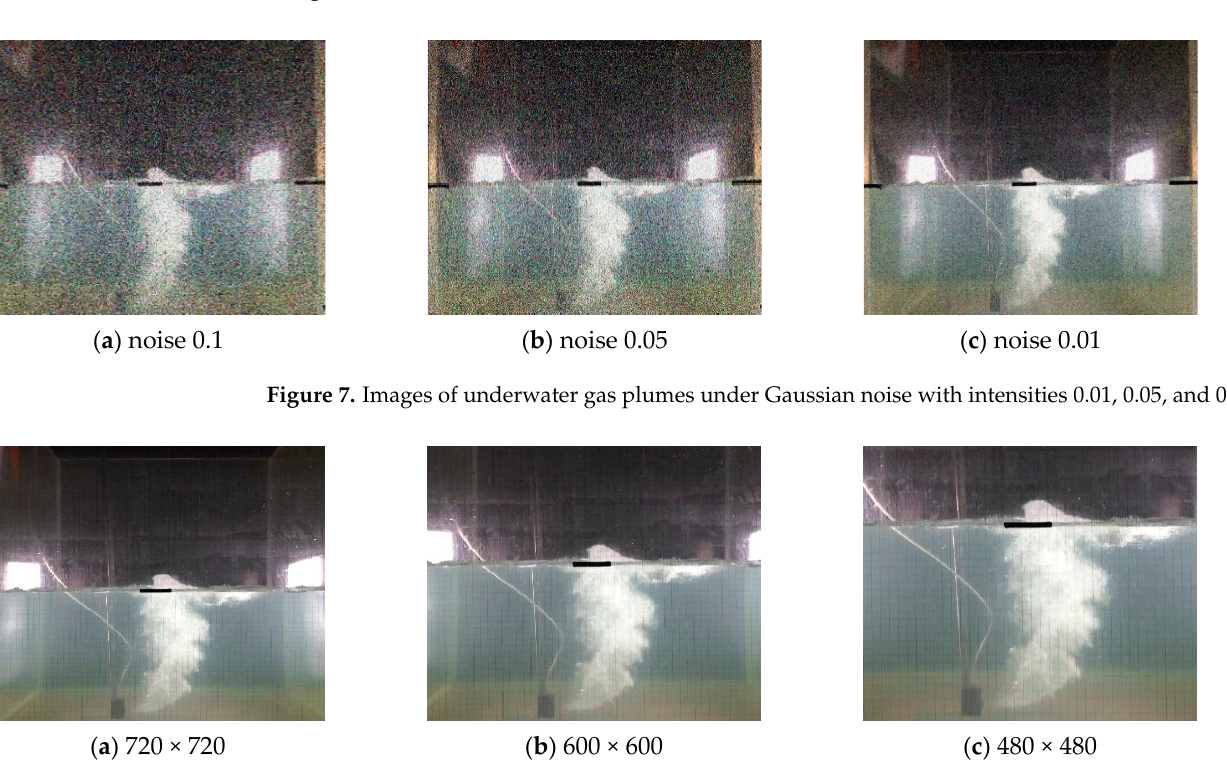
Figure 8. Images of underwater gas plumes under image sizes of (720 × 720), (600 × 600), and (480 × 480).